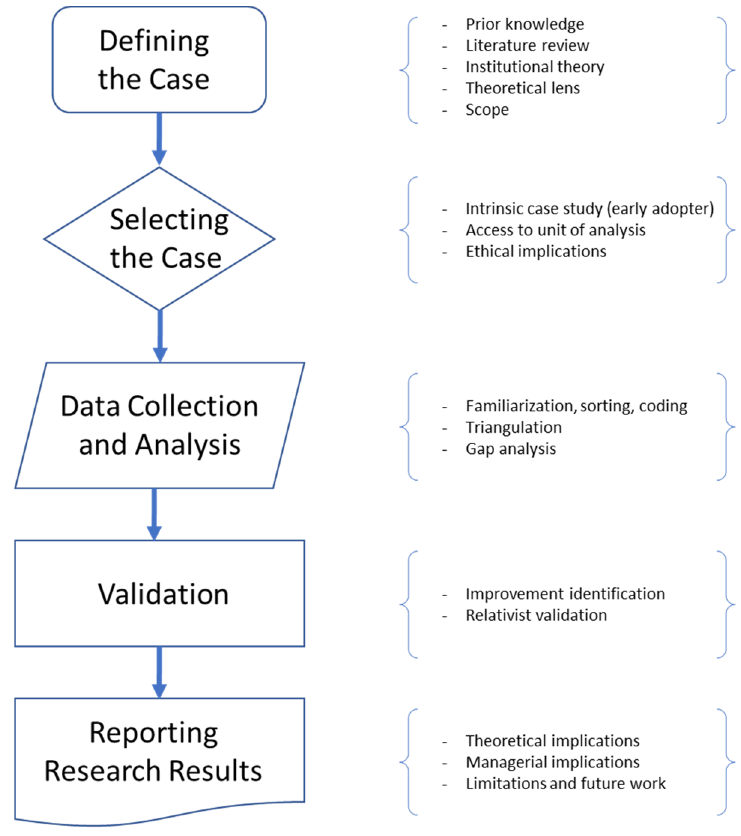
Figure 1. The process flow of this